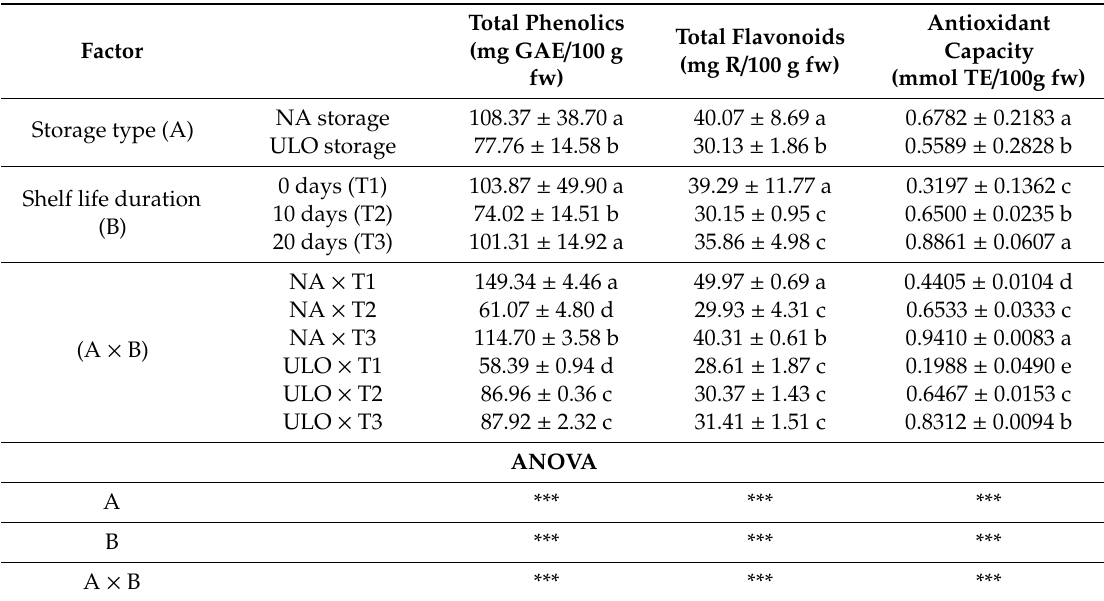
Table 2. The e ff ect of storage type and shelf life duration on total phenolics, total flavonoids contents, and antioxidant capacity in ‘Idared’